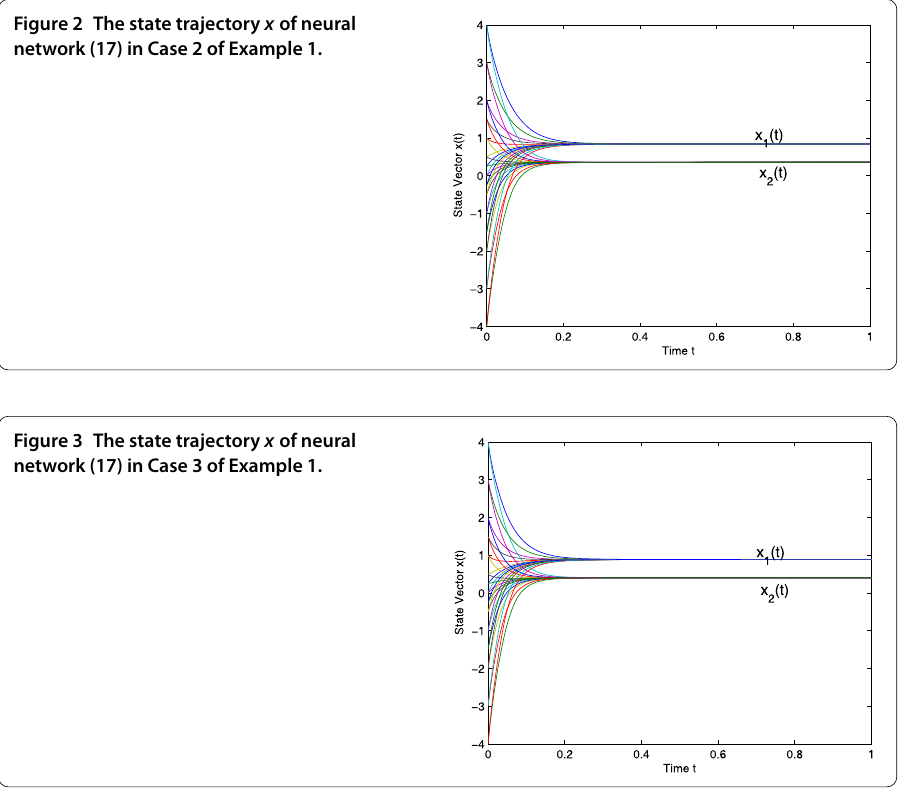
Figure 2 The state trajectory x of neural network (17) in Case 2 of Example 1.